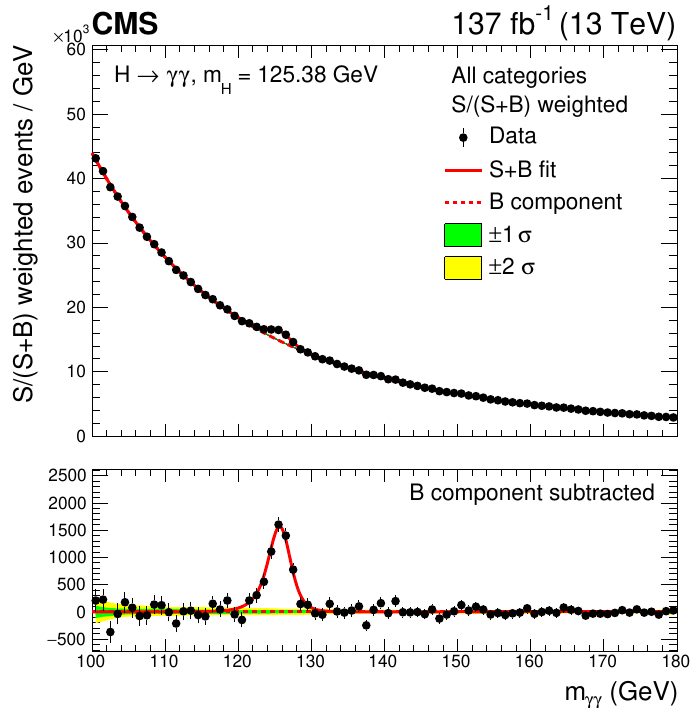
Figure 14 . Data points (black) and signal-plus-background model fit for the sum of all analysis categories is shown. Each analysis category is weighted by S/(S+B), where S and B are the numbers of expected signal and background events, respectively, in a ± 1 σ one (green) standard deviation and two (yellow) standard deviation bands show the uncertainties in the background component of the fit. The solid red line shows the total signal-plus-background contribution, whereas the dashed red line shows the background component only. The lower panel shows the residuals after subtraction of this background